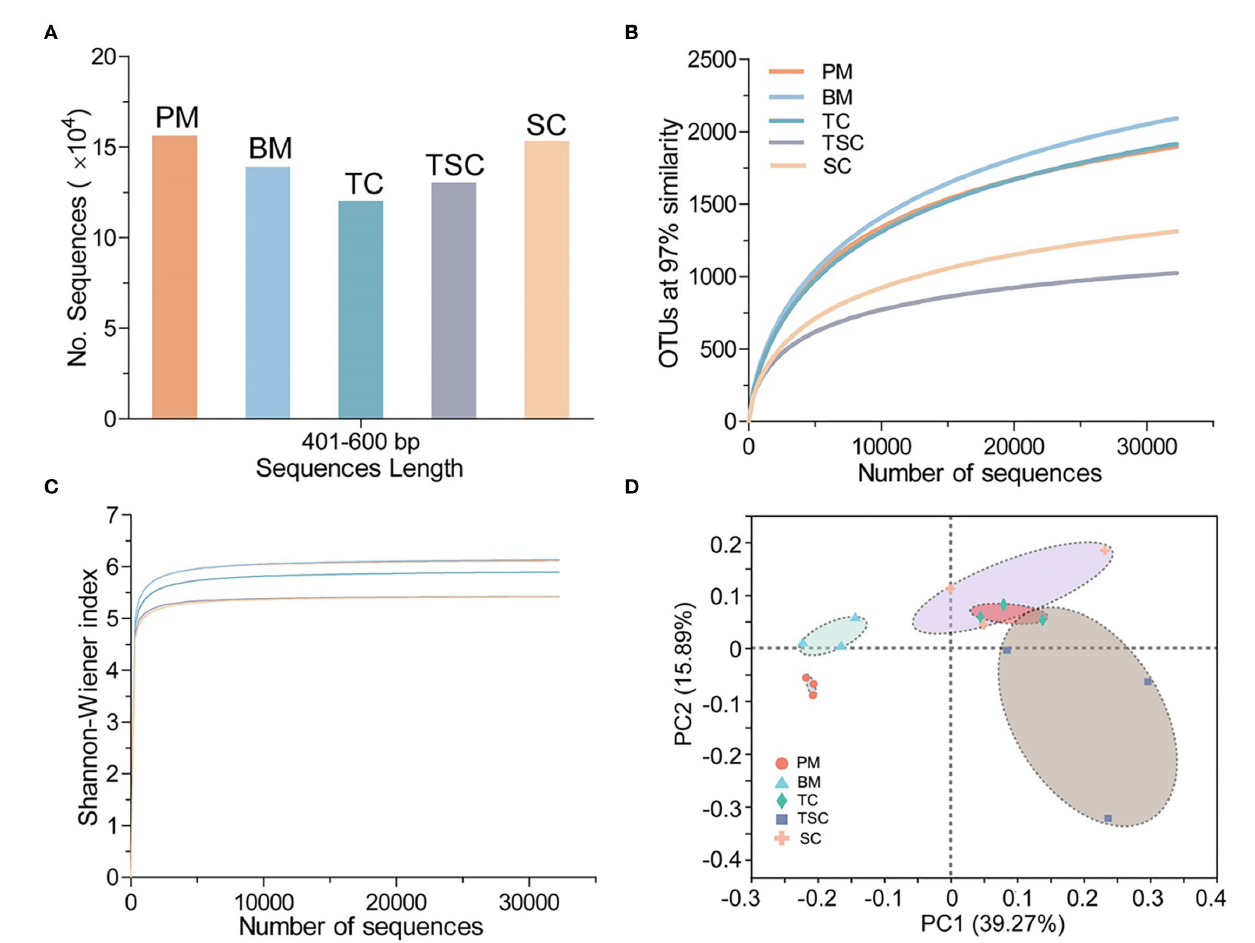
TABLE 2 | The bacterial communities in valid sequence reads, 97% OTUs, Good’s Coverage, and bacterial α -diversity indices. Site